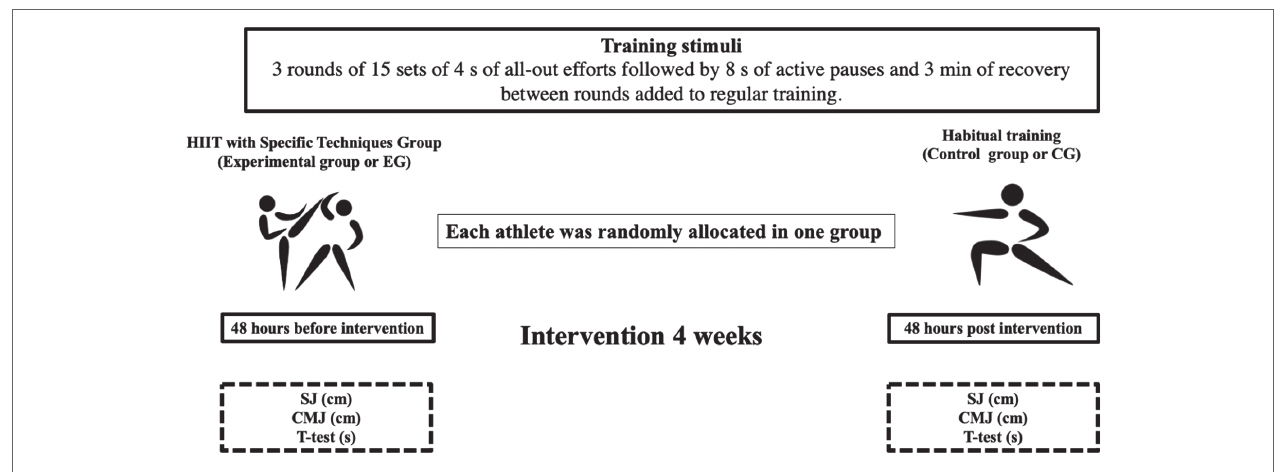
FIGURE 2 | Graphic representation of the experimental design of the study. SJ, squat jump and CMJ, countermovement